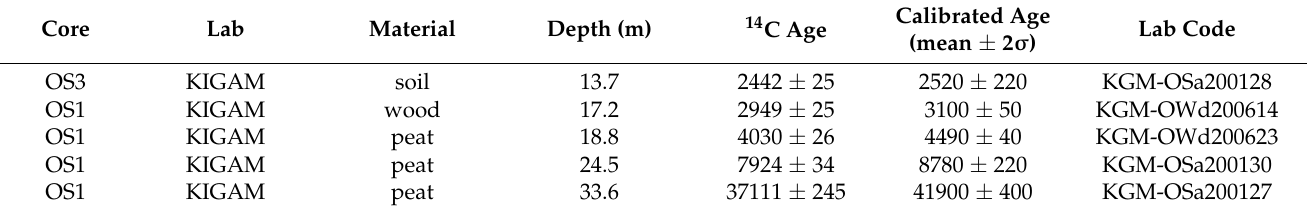
Table 1. List of radiocarbon dates. Details on radiocarbon dates from cores OS1 and